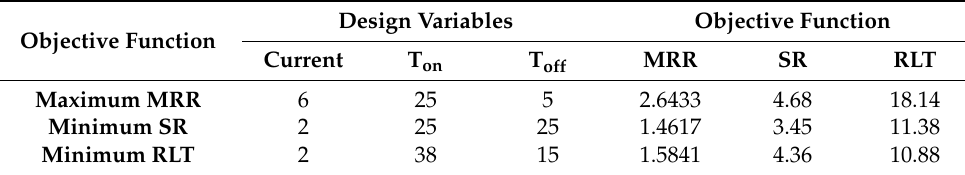
Table 7. Single Objective Optimization using PVS